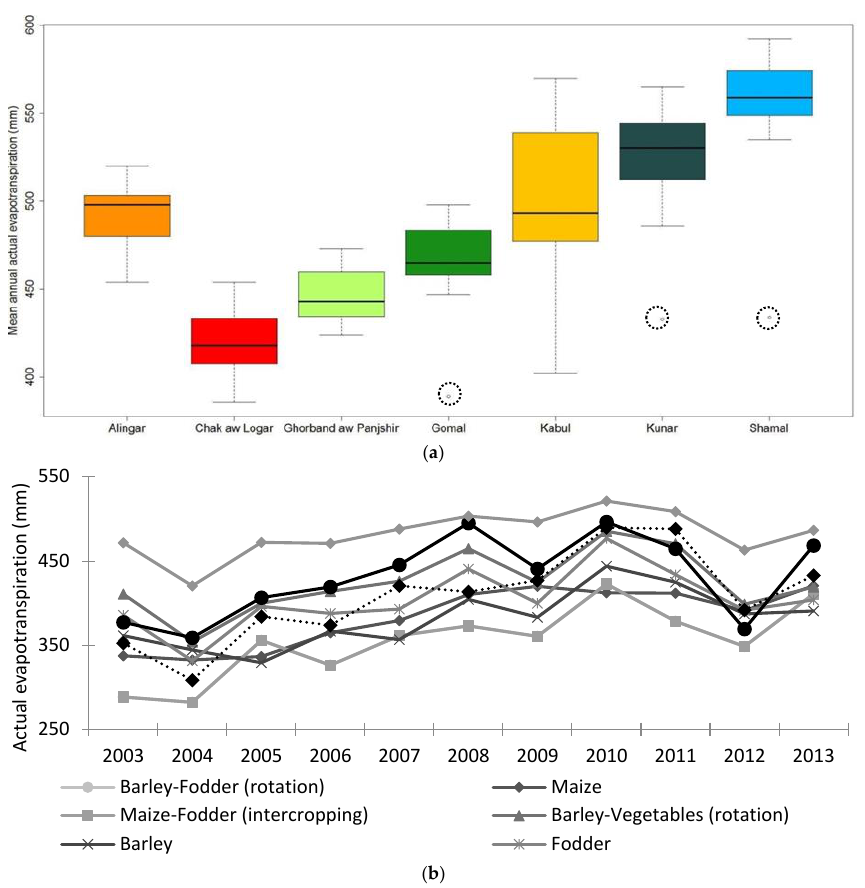
Figure 5. ( a ) Box and whiskers plot of annual evapotranspiration (ET a ), showing the temporal (2003–2013) and spatial variation of the ET a . The horizontal line inside each box represents the median, the lower and upper whiskers show the ET a range during the study period. The outliers are encircled with a dotted line. ( b ) Temporal variation (2003–2013) of actual evapotranspiration of main land covers across the Kabul River